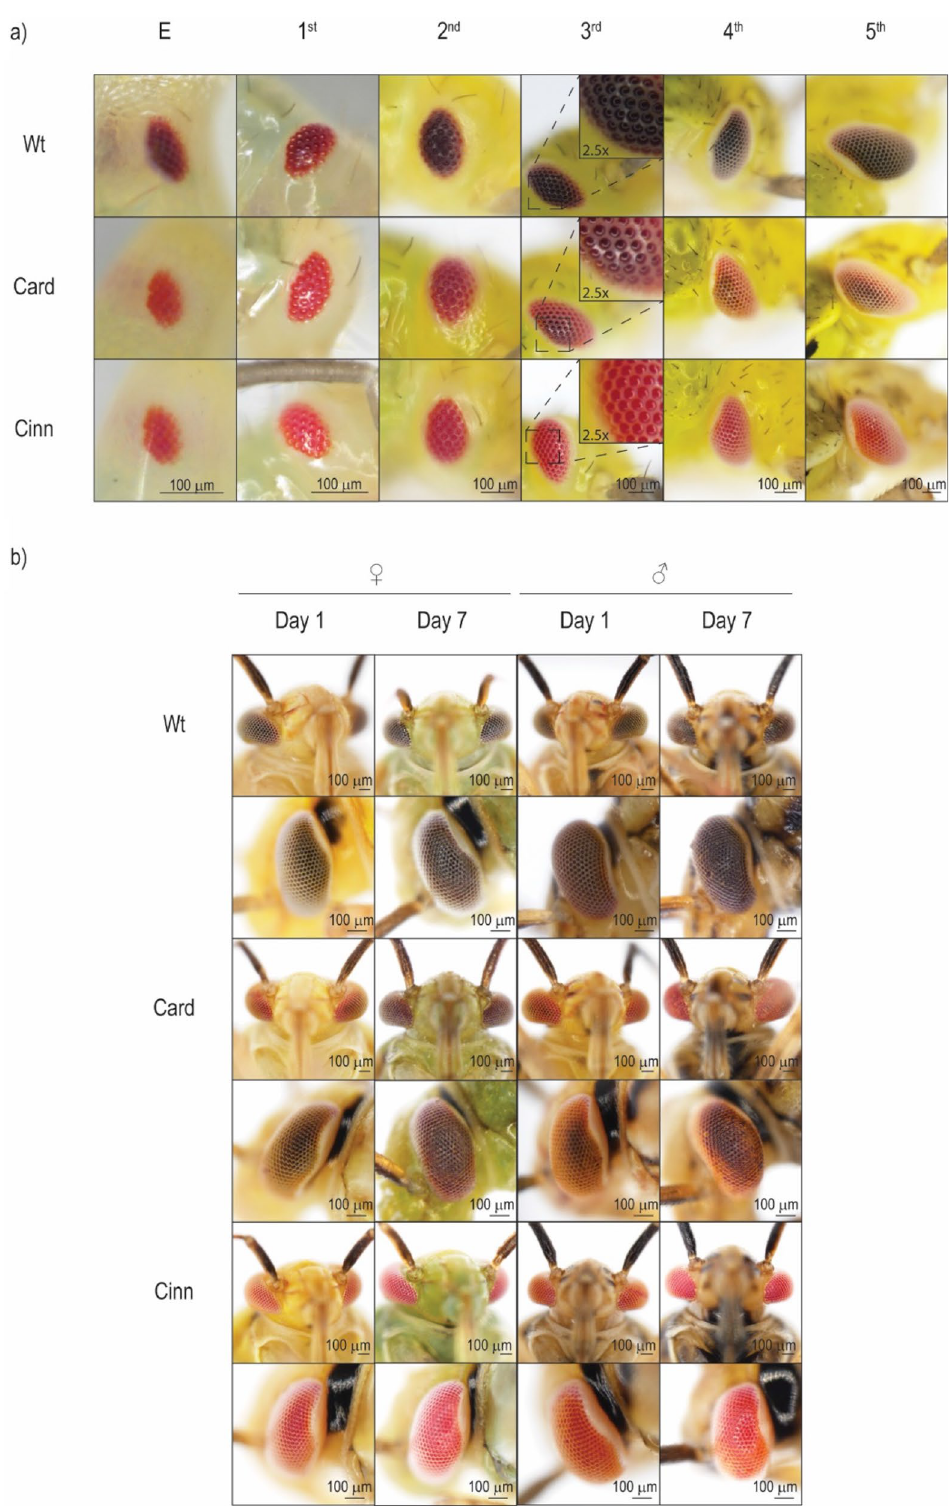
Figure 5. Eye pigmentation phenotypes for the CRISPR/Cas9 Lygus hesperus mutant strains. ( a ) Egg (E) and nymphal instars (1st, 2nd, 3rd, 4th, and 5th) corresponding to representative wild-type, Card, and Cinn insects. Insets show 2.5 × magnification of the 3rd instar eye, which underscores gradual reversion to wild-type coloration in the Card line. ( b ) Ventral and lateral views of female and male eyes at 1-day and 7-days post-